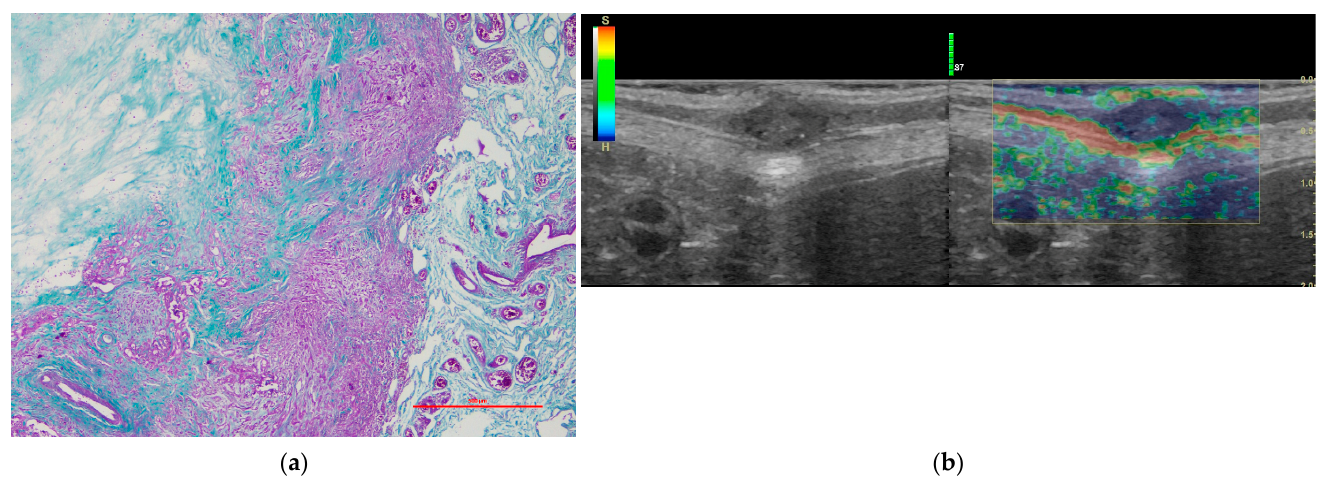
Figure 1. Representative image of a mass confirmed as a complex carcinoma. ( a ) Detail of the cellular composition of the tumoral tissue (H&E). ( b ) Histological detail of the tumor parenchyma of a com ‐ plex carcinoma in which there was low presence of collagen fibers (Masson’s Trichrome). ( c ) B ‐ mode and elastographic images scored as 3 in the visual scale, corresponding to the same complex carci ‐ noma sample.